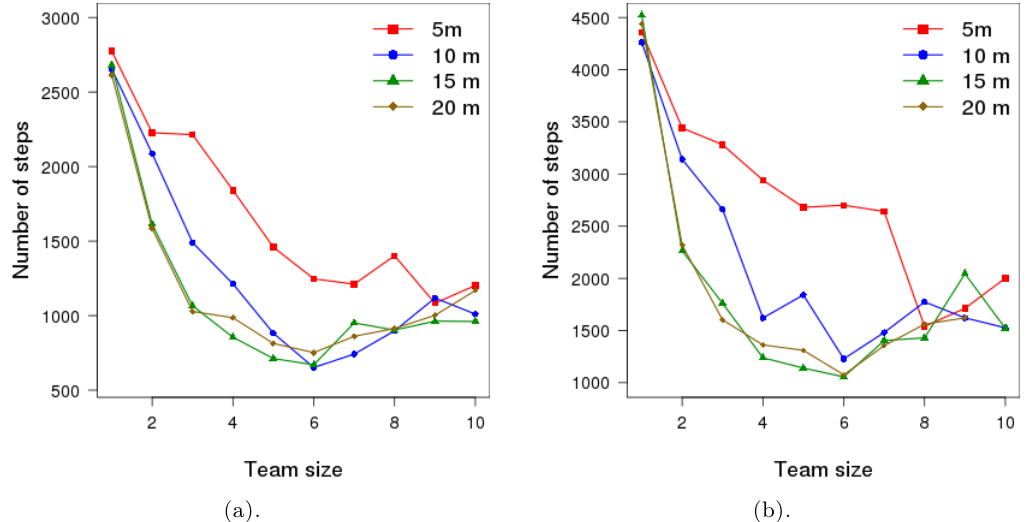
Figure 2. Dependence of the steps on the team size. The value of the laser range is: (a) 2 meters; (b) 1.5 meters.